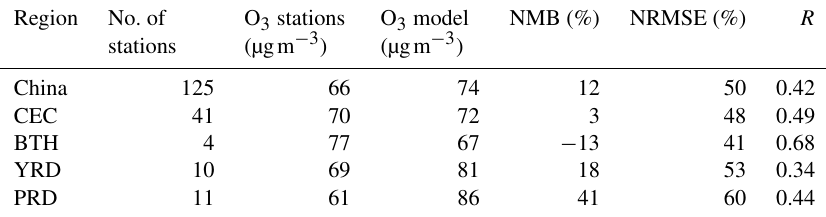
Table 2. Comparison between the daily O 3 concentrations simulated by the INCA model and the daily mean O 3 concentrations measured at the Chinese surface stations for 2014–2017. Due to the model resolution, only the stations classified as rural are used for the comparison. For each region, the number of stations and the mean observed and simulated O 3 concentrations are provided. The normalised mean bias (NMB in percent) is calculated as the difference between the model concentration and the observed one, with the latter used as the reference. The normalised root mean square error (NRMSE in percent) is calculated based on the daily averages, and the correlation coefficient ( R ) corresponds to the temporal and the spatial correlation (the daily time series of each station are considered in its calculation without any regional